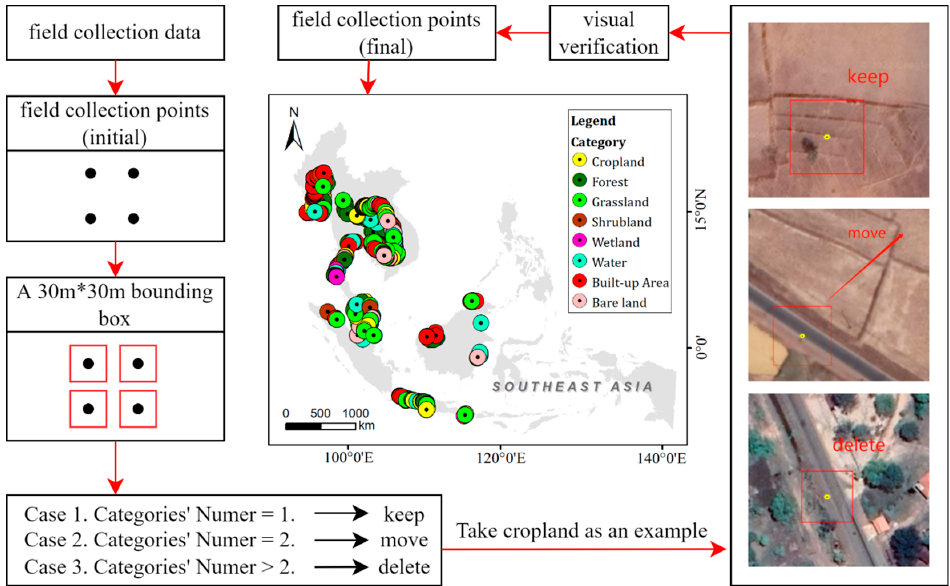
Figure 3. Processing flow and spatial distribution of 3326 field collection points: 1171 cropland points, 1133 forest points, 388 grassland points, 138 shrubland points, 64 wetland points, 94 water points, 208 built-up area points, and 130 bare land points.